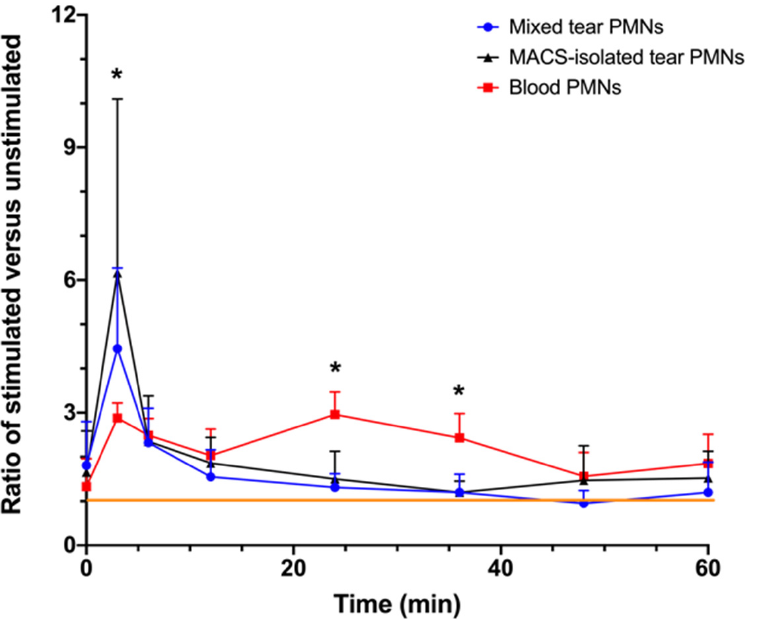
Figure 3. Changes in chemiluminescence (CL) of fMLP-stimulated PMNs. Results are reported as ratio of fMLP-stimulated CL emissions over control (unstimulated) sample CL emissions. A total of 50,000 cells were transferred to wells containing 1 mM luminol and HBSS, followed by the addition of 1.5 μ M fMLP. Generation of ROS was measured over time using the Cytation 5 at 37 °C. The orange line indicates a ratio of 1, meaning no difference between stimulated and unstimulated CL values. Values are presented as means ± standard deviations; mixed tear PMNs (n = 14-16 from 16 participants), MACS-isolated tear PMNs (n = 10 from 8 participants), and blood PMNs (n = 5 from 4 participants). * Significantly different from tear PMNs and blood PMNs ( p ≤ 0.02).